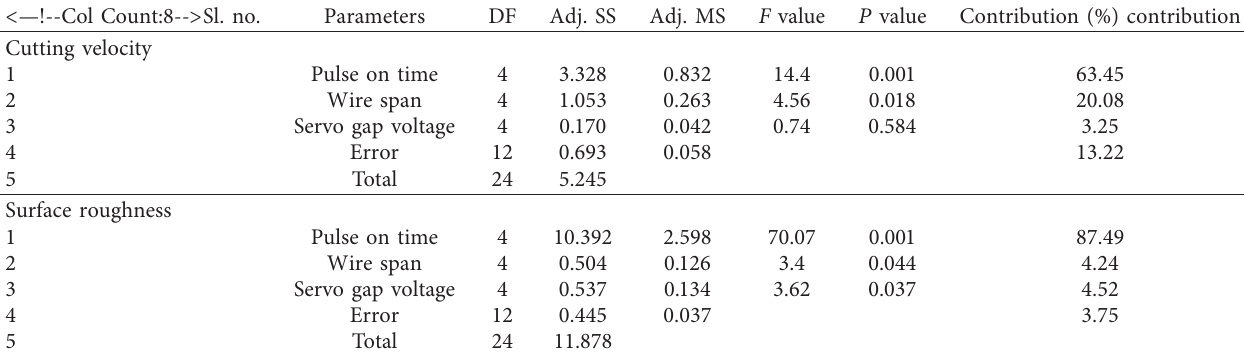
Table 4: ANOVA for cutting velocity and surface